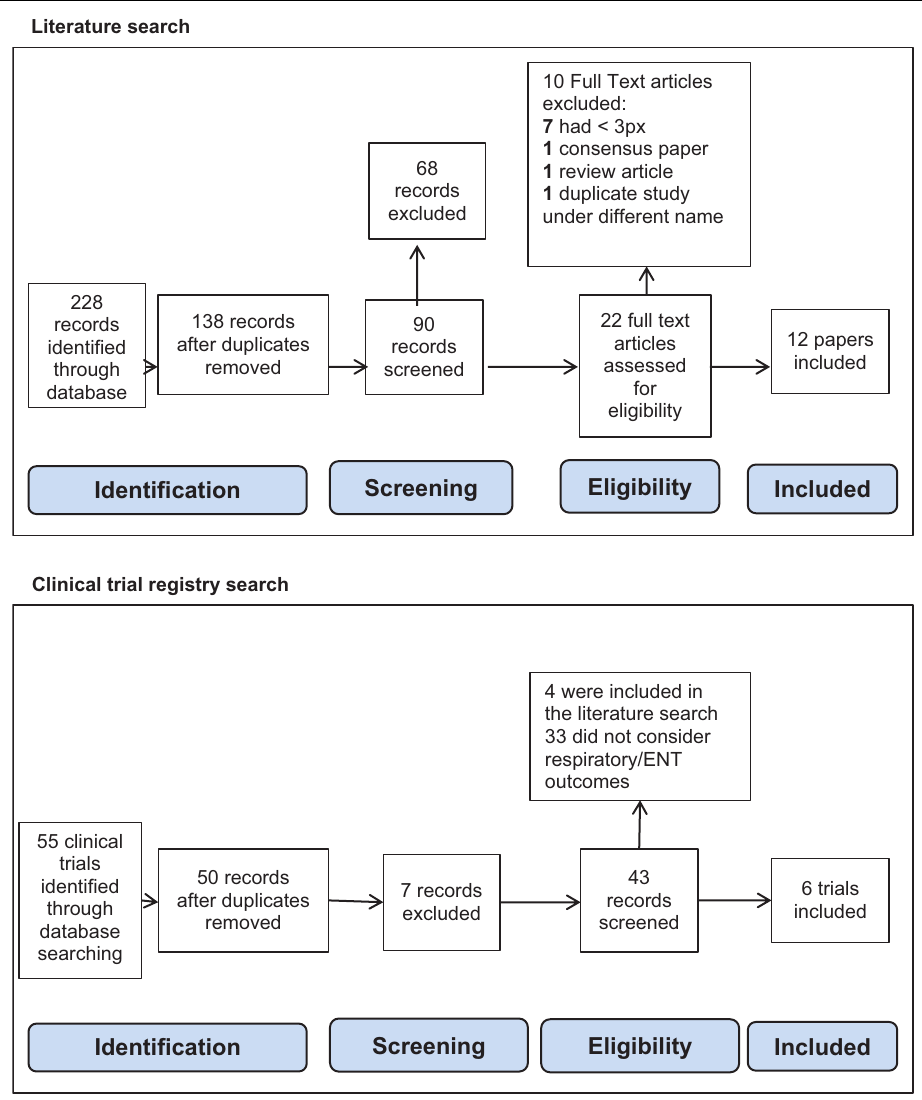
Figure 1. Preferred Reporting Items for Systematic Reviews and Meta-analysis (PRISMA) flowchart illustrating the review of